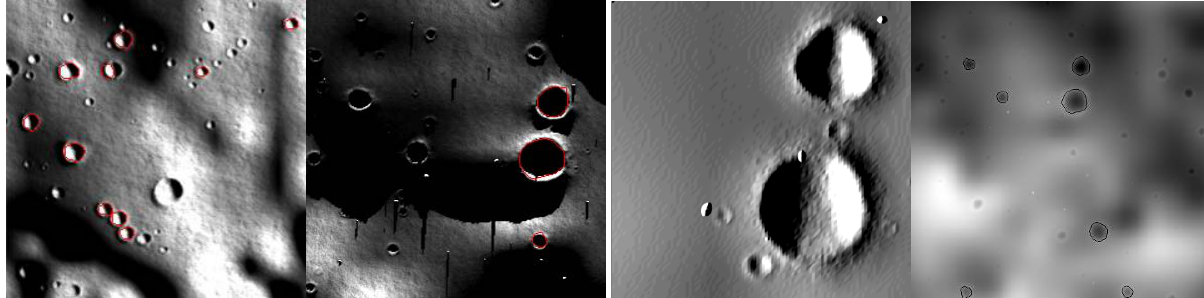
Figure 3. Crater extraction in camera images with Sun elevation around 45º (leftmost) and Sun elevation around 1º (left-center); LiDAR image after Sobel operator in the horizontal direction (right-center), and crater identification in LiDAR image